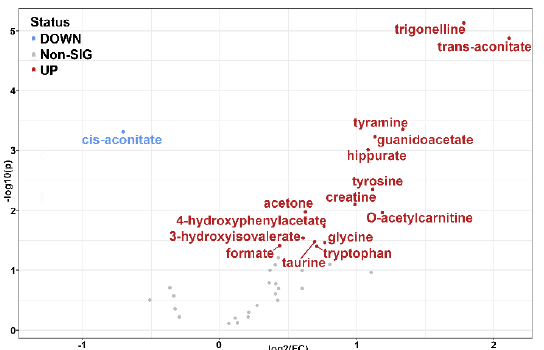
Figure 4. Volcano plot of the fold change vs. p -value for the metabolite dataset; the binary logarithm of fold change is used to increase the dynamic range. Significant metabolites ( p < 0.05) are labeled and colored according to the increase (red) or decrease (blue) for AKU vs. controls. Homogentisate values from Table 2 have been omitted for clarity because of their high range.